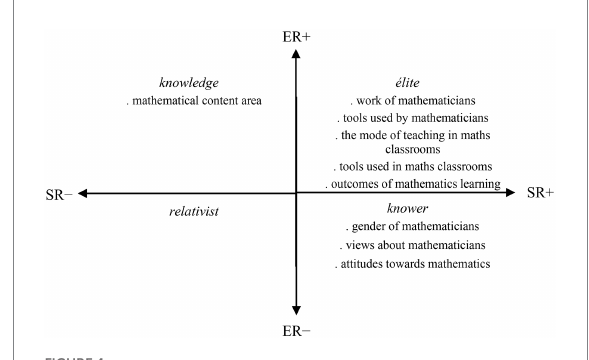
FIGURE 4 Mapping of the DAMT study focuses on the specialization